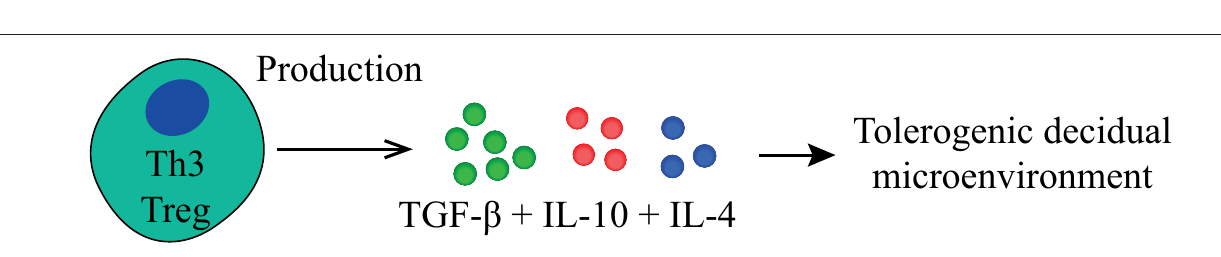
FIGURE 4 | Main tolerogenic mechanisms of the Th3 regulatory T cell. Th3 regulatory T cells suppress in a cell-contact independent mechanism only by the production of TGF- β , IL-10 and differ here from the Tr1 regulatory T cell by the production of IL-4. TGF- β , transforming growth factor-beta; IL,